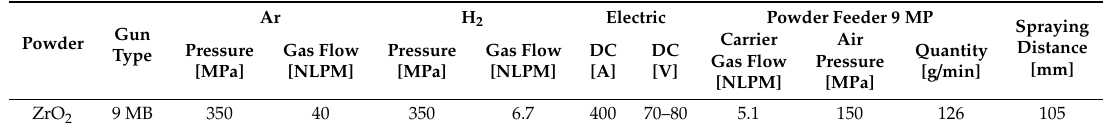
Table 2. Deposition parameters of ceramic